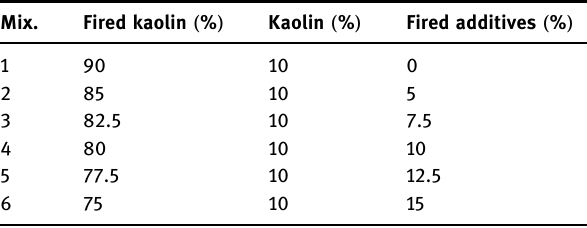
Table 1: Proportions of raw materials utilised in the mix